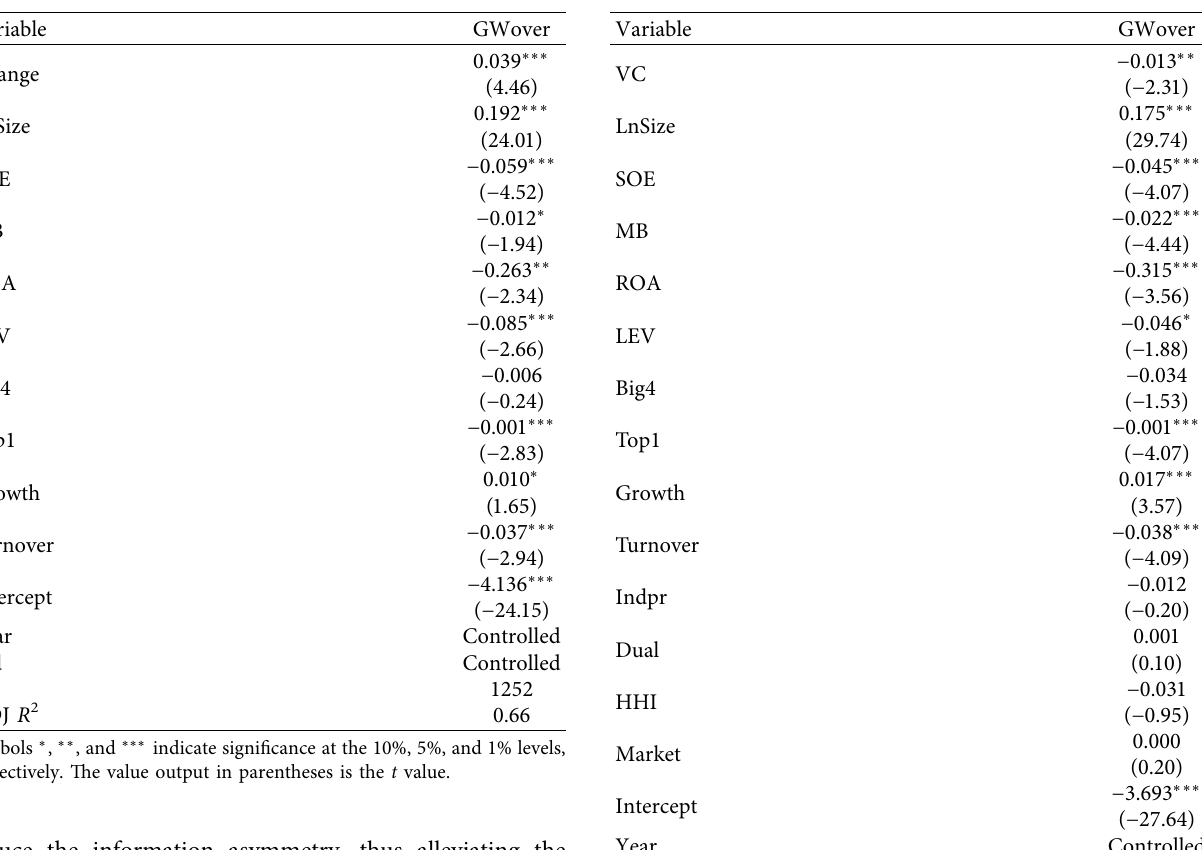
Table 8: DID regression results. Table 9: Regression results of adding control